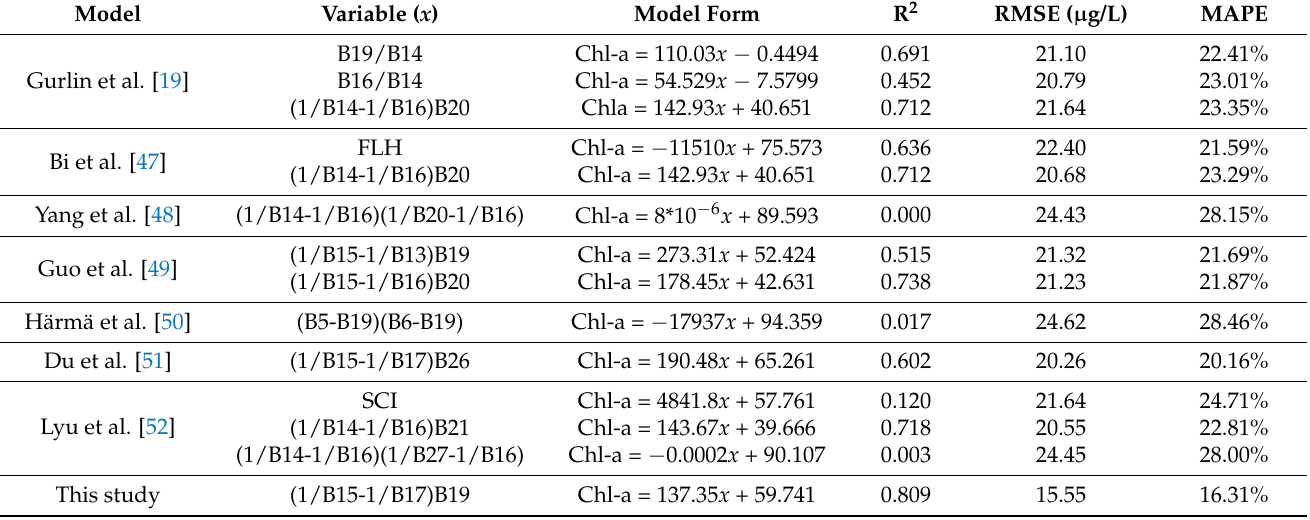
Table A3. Comparison of Chl-a concentration estimation results of this study and existing algorithms applied to Dianchi Lake. Bi is the band of the OHS image corresponding to the wavelength in the citation. SCI stands for Synthetic Chlorophyll Index